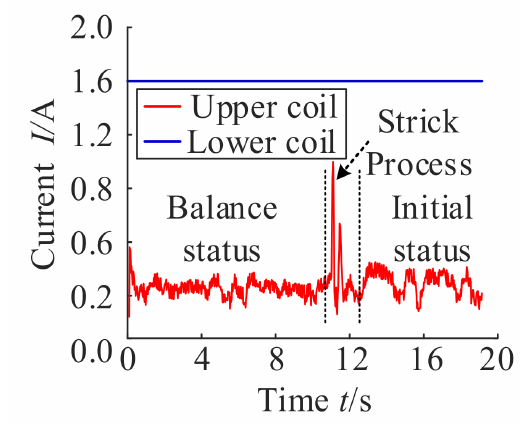
Figure 20. Current of coil by test when K p = − 70.